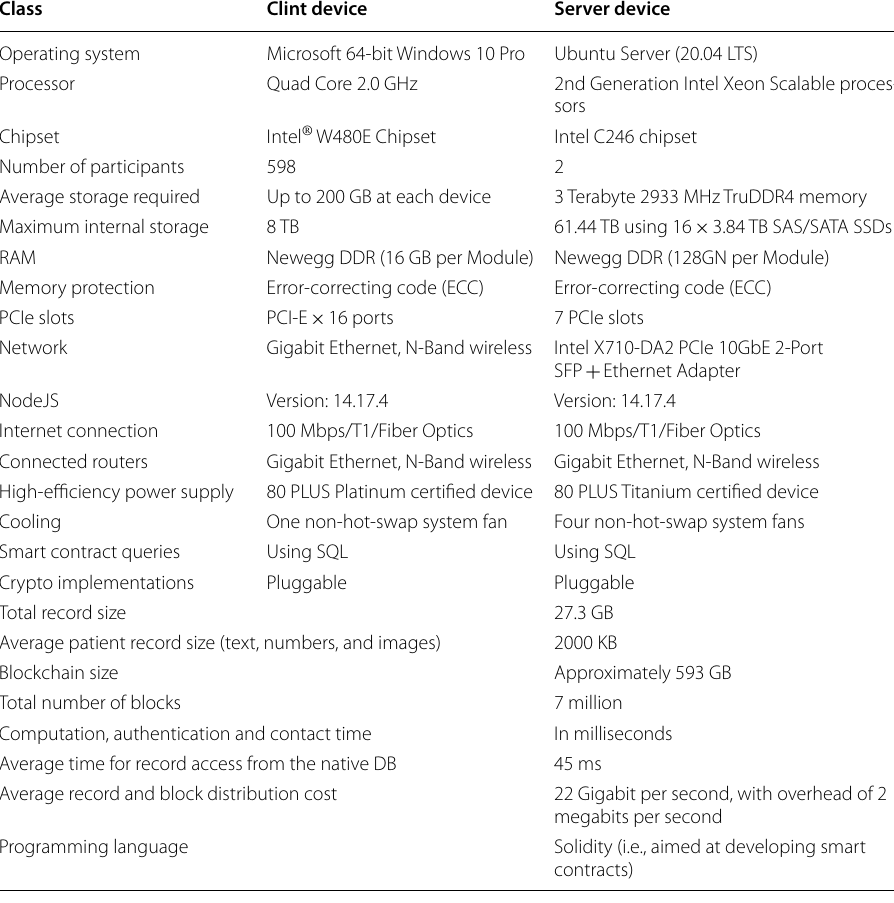
Table 3 Applied hardware and software configurations for hyperledger fabric blockchain infrastructure